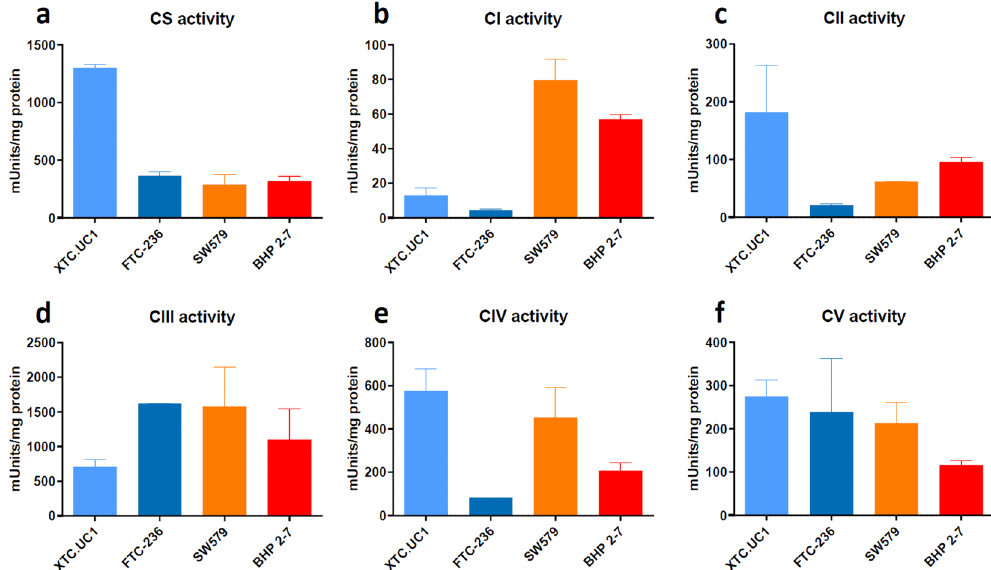
Figure 1. Absolute activities of citrate synthase and OXPHOS complexes in XTC.UC1, FTC-236, SW579 and BHP2-7; ( a ). citrate synthase (CS); ( b ). CI; ( c ). CII; ( d ). CIII; ( e ). CIV; ( f ). CV. Values are given as mean ± SEM. Measurements were repeated twice and each measurement includes two replicates. Note the high CS activity in XTC.UC1 and the significant loss of CI activity in both XTC.UC1 and FTC-236. CII, CIII, CIV and CV activities are more variable between the four cell